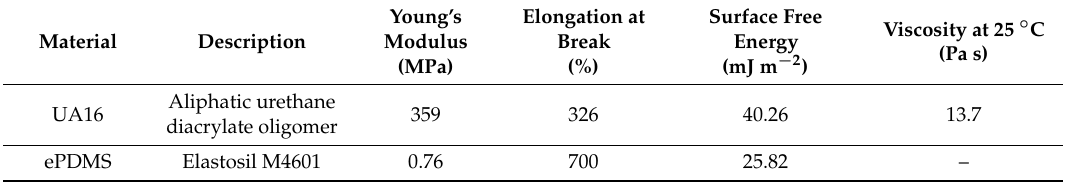
Table 1. Material properties of UA16 (adhesive material) and ePDMS